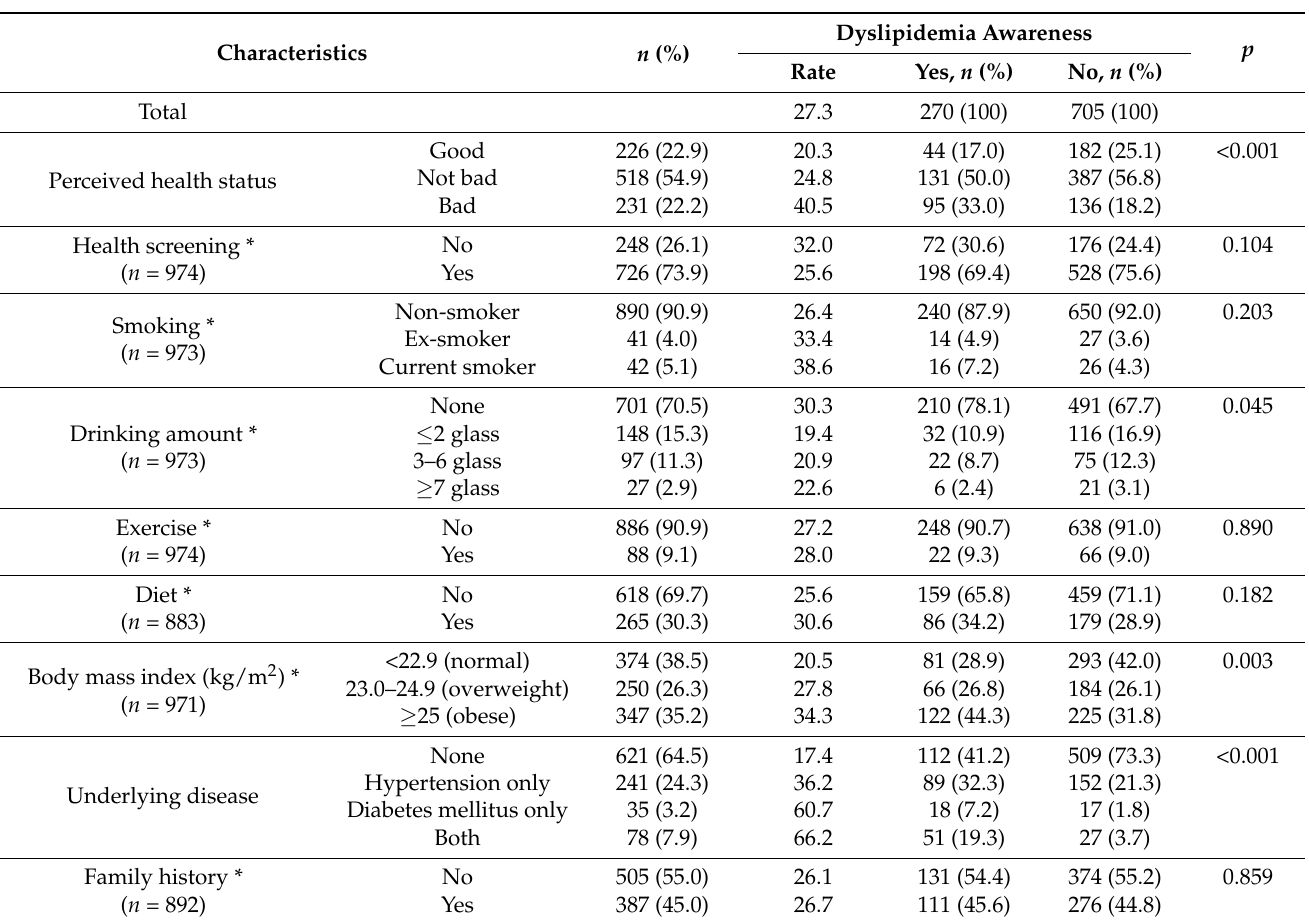
Table 2. Health-related characteristics and dyslipidemia awareness level in menopausal women ( n =